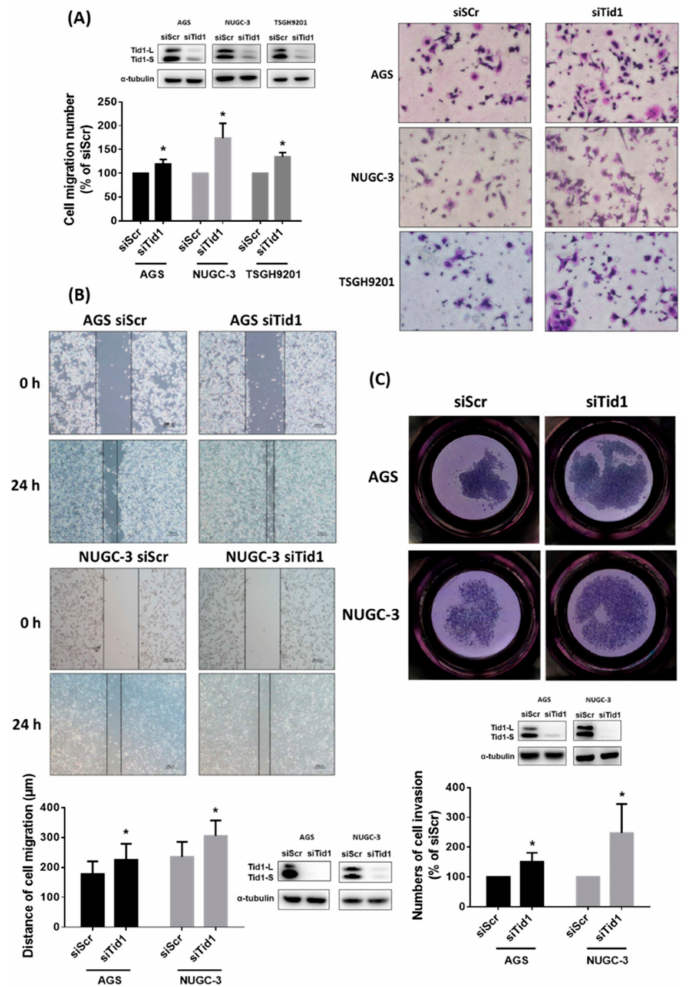
Figure3. EffectofTid1knockdownoncellmigrationandinvasionofgastriccancercells. ( A , B